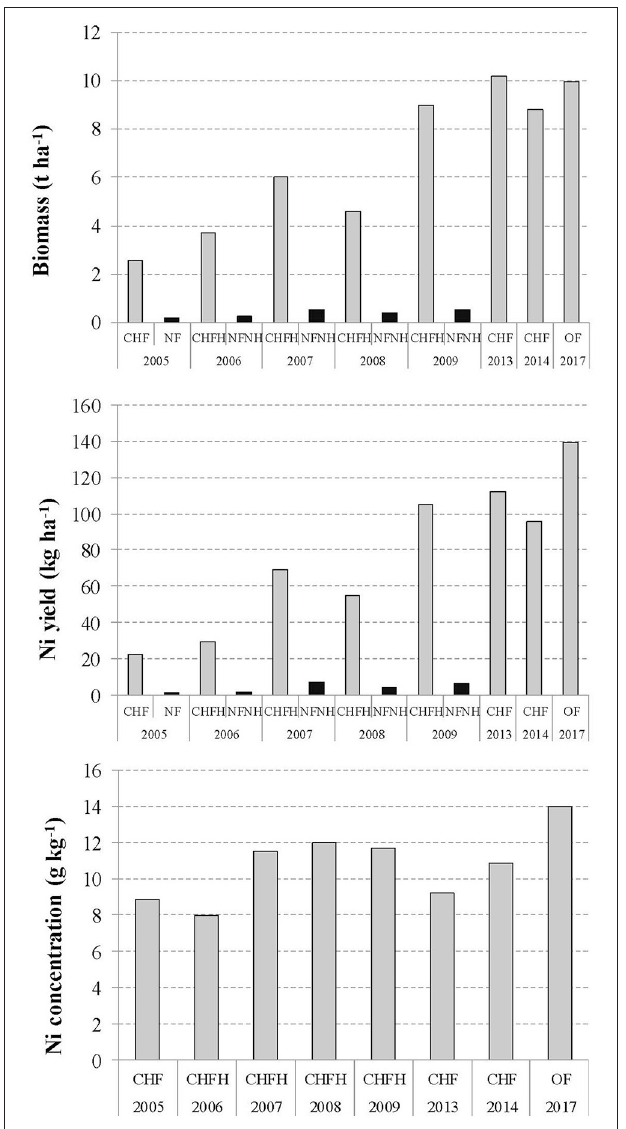
FIGURE 4 | Evolution of biomass production, Ni phytoextracted yield and shoot Ni concentration of Odontarrhena muralis s.l. during 8 years of a field study in Pojska, Pogradec (Albania). CHF-chemical fertilizer, NF-no fertilizer, H-herbicide, OF-organic fertilizer. Modified with permission from Echevarria (2018); Bani and Echevarria (in press) and Bani et al. (2007, 2015a).